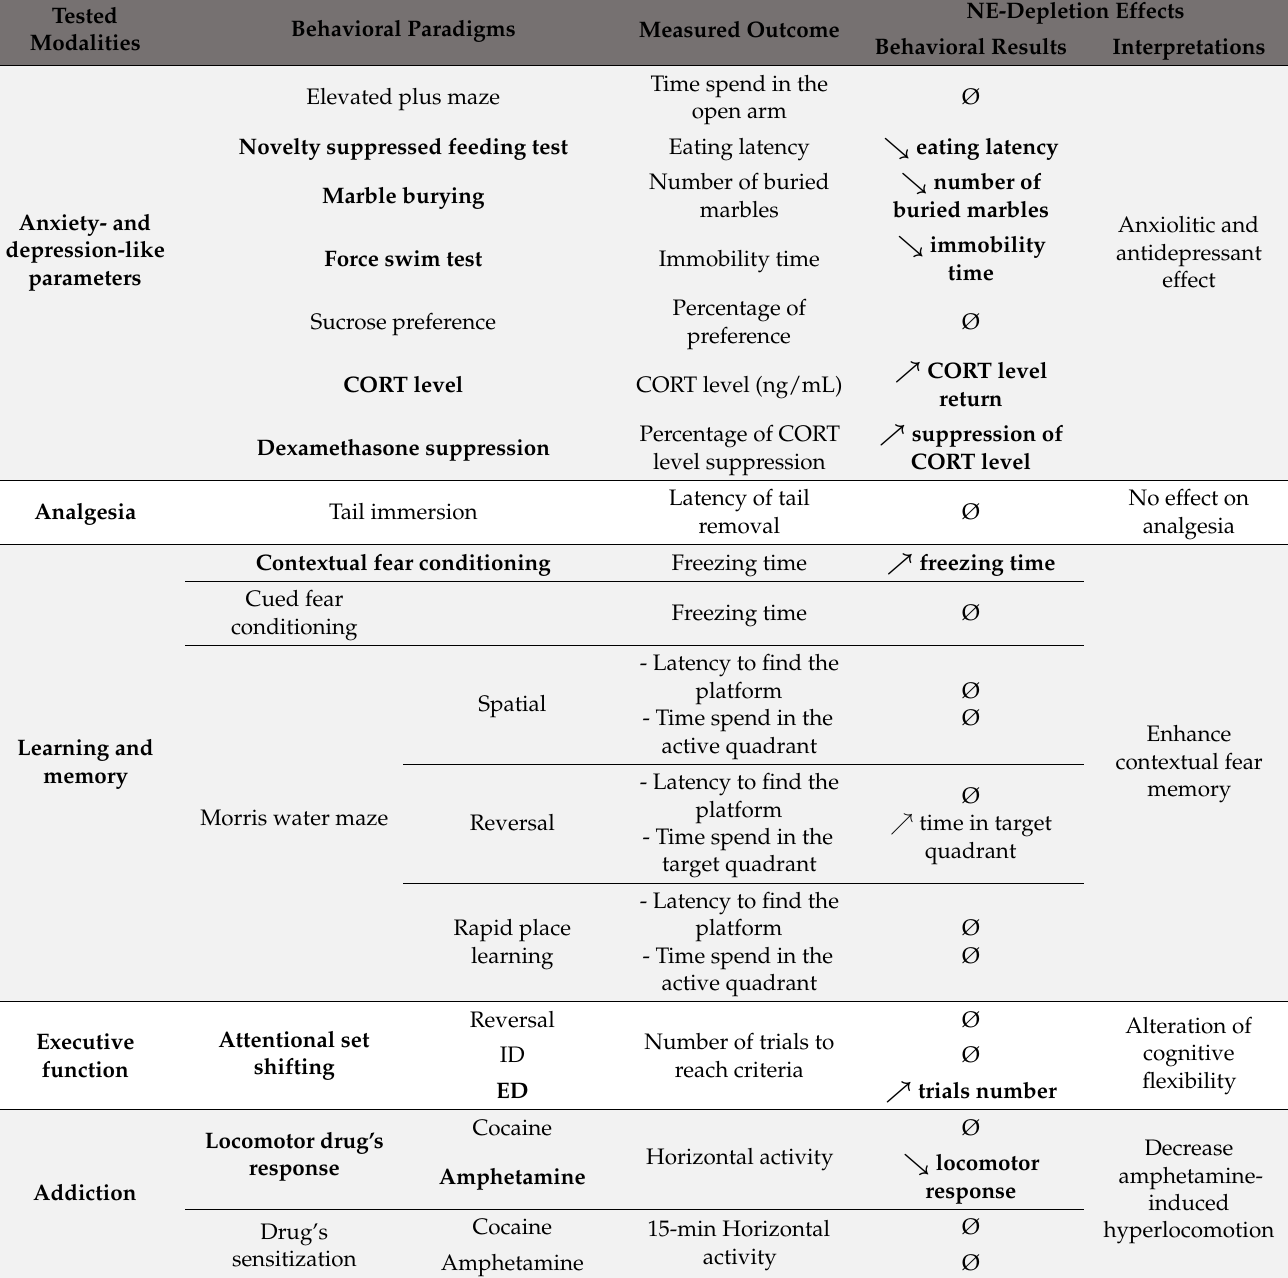
Table 2. Behavioral results summary in VMAT2 DBHcre